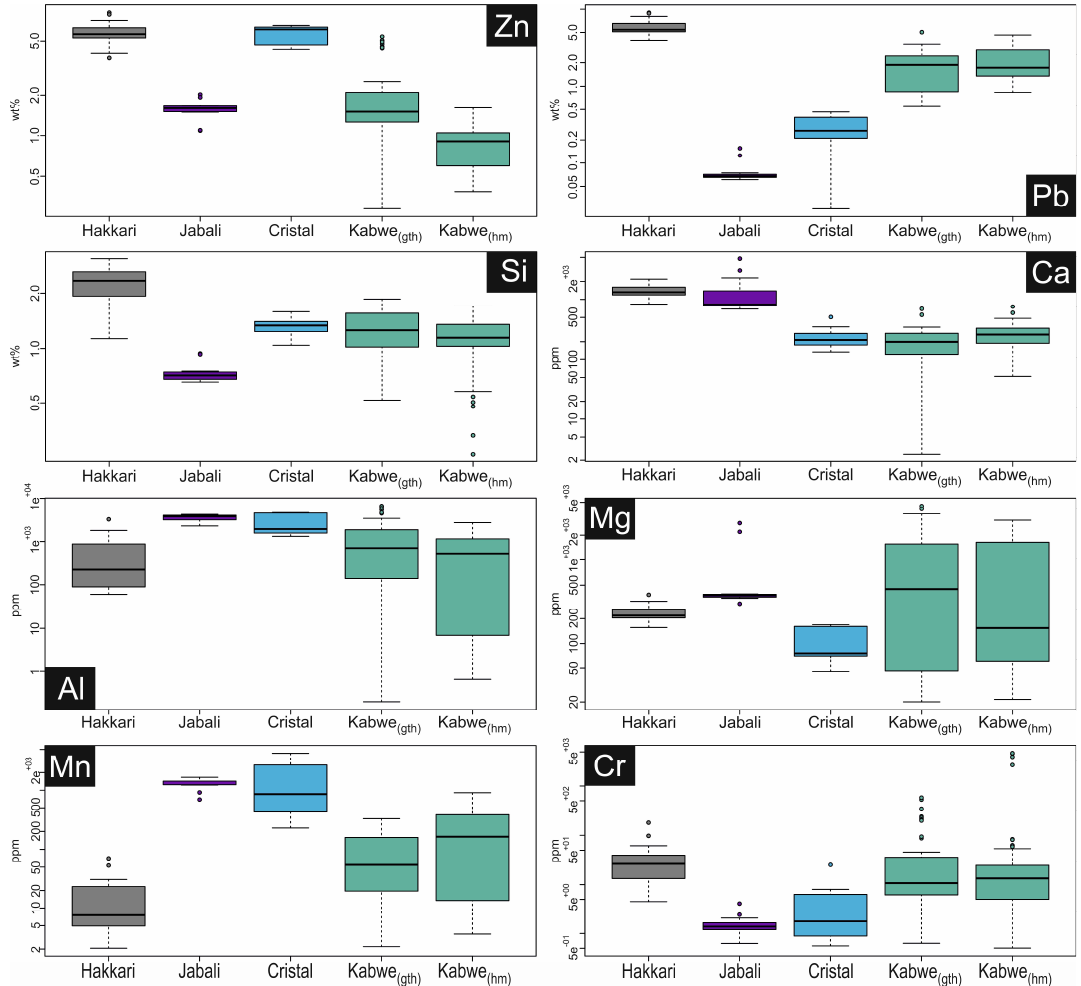
Figure 3. Box and whisker plots showing the chemical composition of the studied FeO/OH from Hakkari and Jabali. Data from Cristal and Kabwe are also reported [18,19].